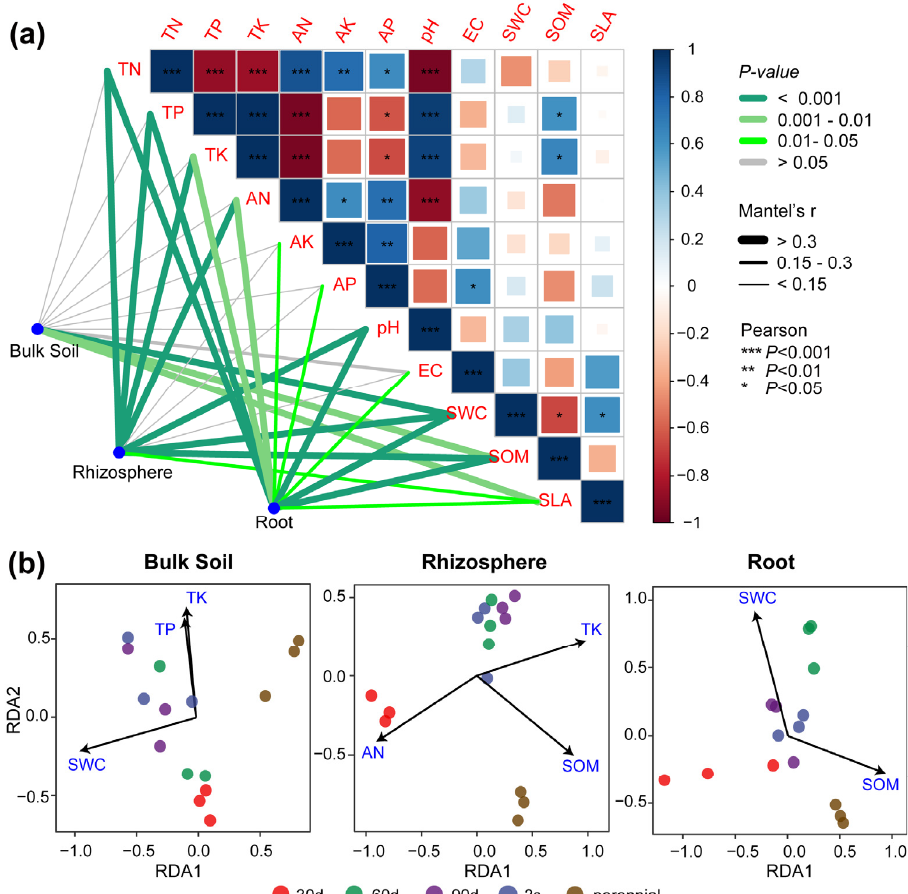
Figure 3. The correlations between the mycobiome and environmental factors. ( a ) Mantel test results show Spearman’s correlations between the mycobiome and environmental factors. The correlation heat map on the upper right shows Pearson’s correlations between environmental factors. ( b ) Redundancy analysis (RDA) results show the relationships between edaphic factors and genus-level community structures tested by 999 permutations. The specific partition of these main edaphic factors is presented in Figure S3. Abbreviations: 30 d, 30 days old; 60 d, 60 days old; 90 d, 90 days old; 2 a, 2 years old; perennial, over 3 years old. TN, total nitrogen (g/kg); TP, total phosphorus (g/kg); TK, total potassium (g/kg); AN, available nitrogen (mg/kg); AP, available P (mg/kg); AK, available potassium (mg/kg); EC, electrical conductivity (mS/cm); SWC, soil water content; SOM, soil organic matter (g/kg); SLA, specific leaf area (cm 2 /g).